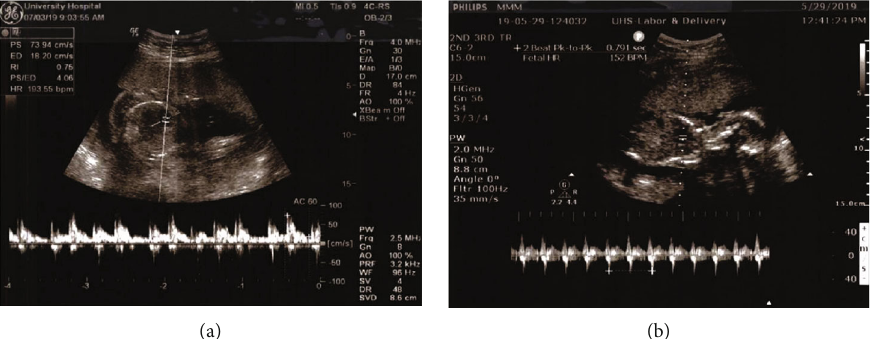
Figure 2: Transabdominal ultrasound of fetus prior to and after fetal intramuscular injection of digoxin. Fetal heart rate is 194bpm after 6 days of treatment with oral digoxin (a). After the procedure, fetal heart rate is 152bpm